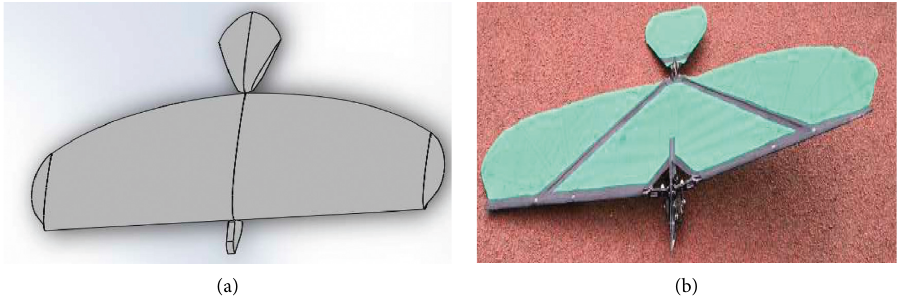
Figure 2: A bird-like flapping wing robot. where (a): the physical model of the robot; (b): the robot prototype.